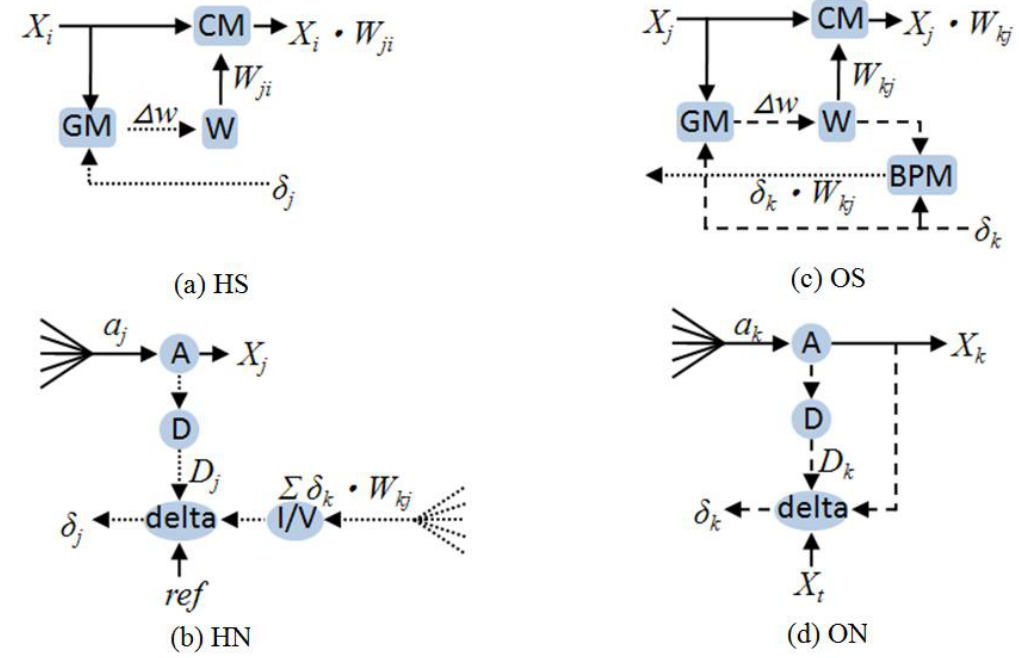
Figure 2. Detailed block diagrams of HS, HN, OS, and ON.